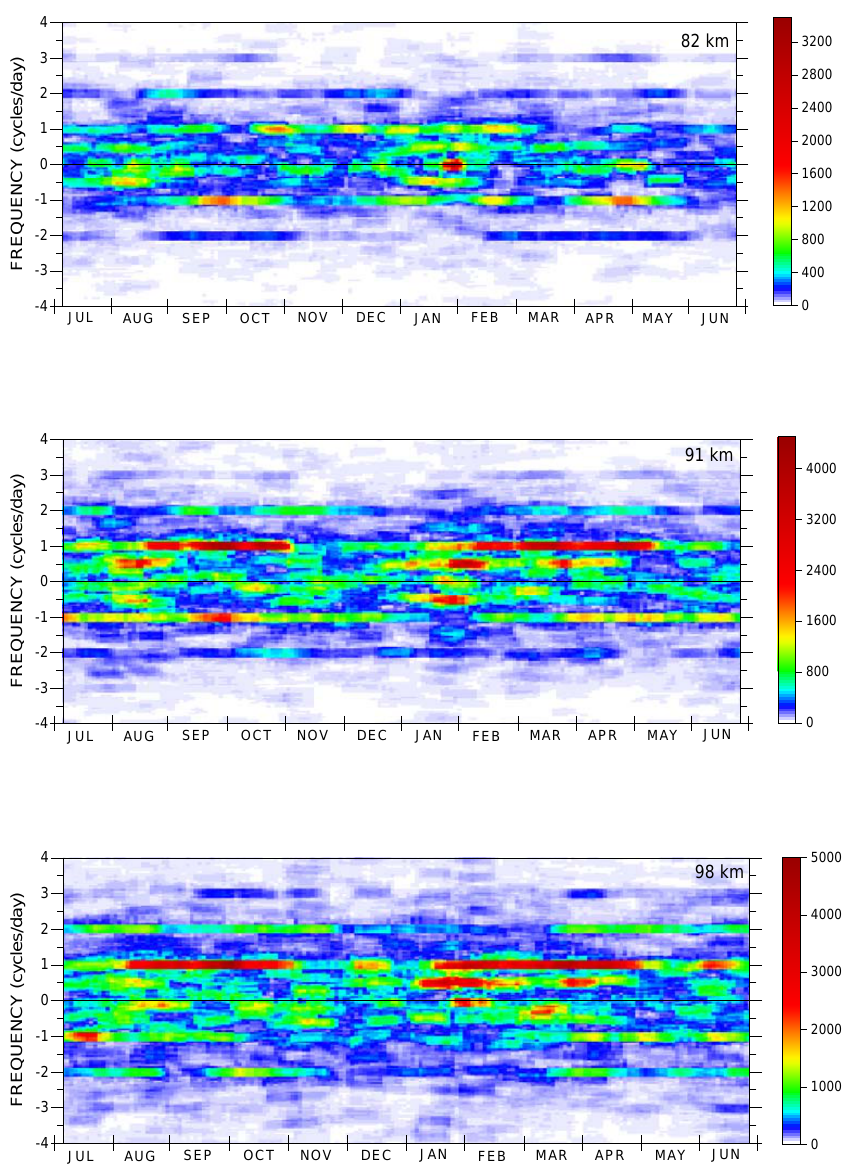
Fig. 13. Running power spectrum of the wind at Cariri from July 2004 to June 2005 at 82 km (a), 91 km (b) and 98 km (c). The colors represent the power spectra density (m 2 s -2 day).